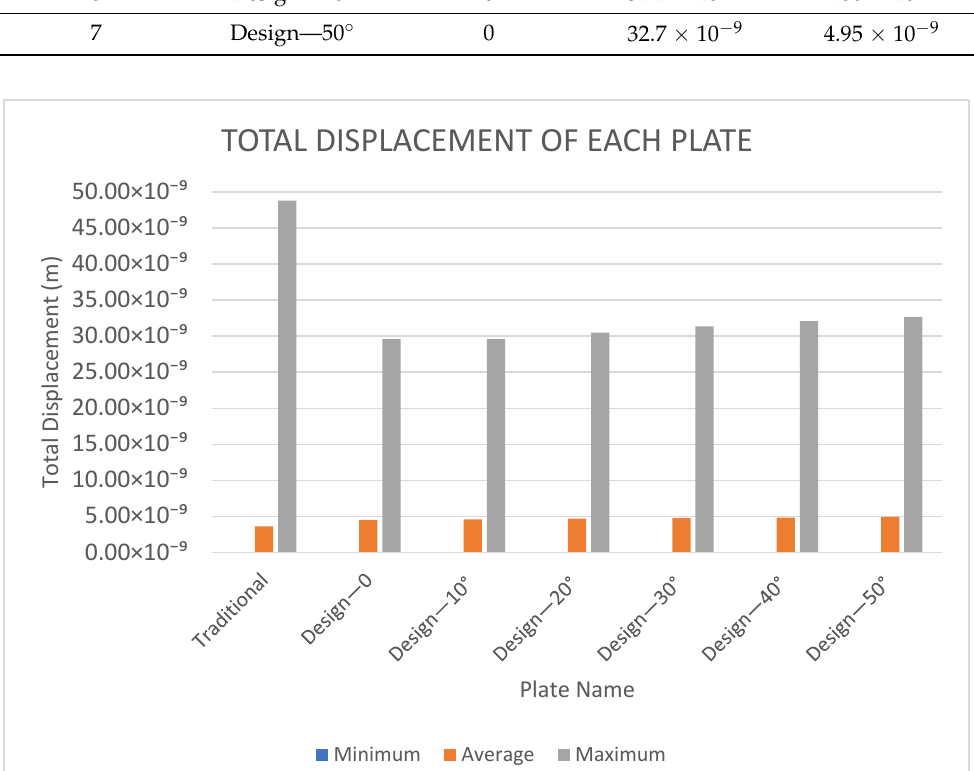
Figure 27. Total displacement (m) of each plate.